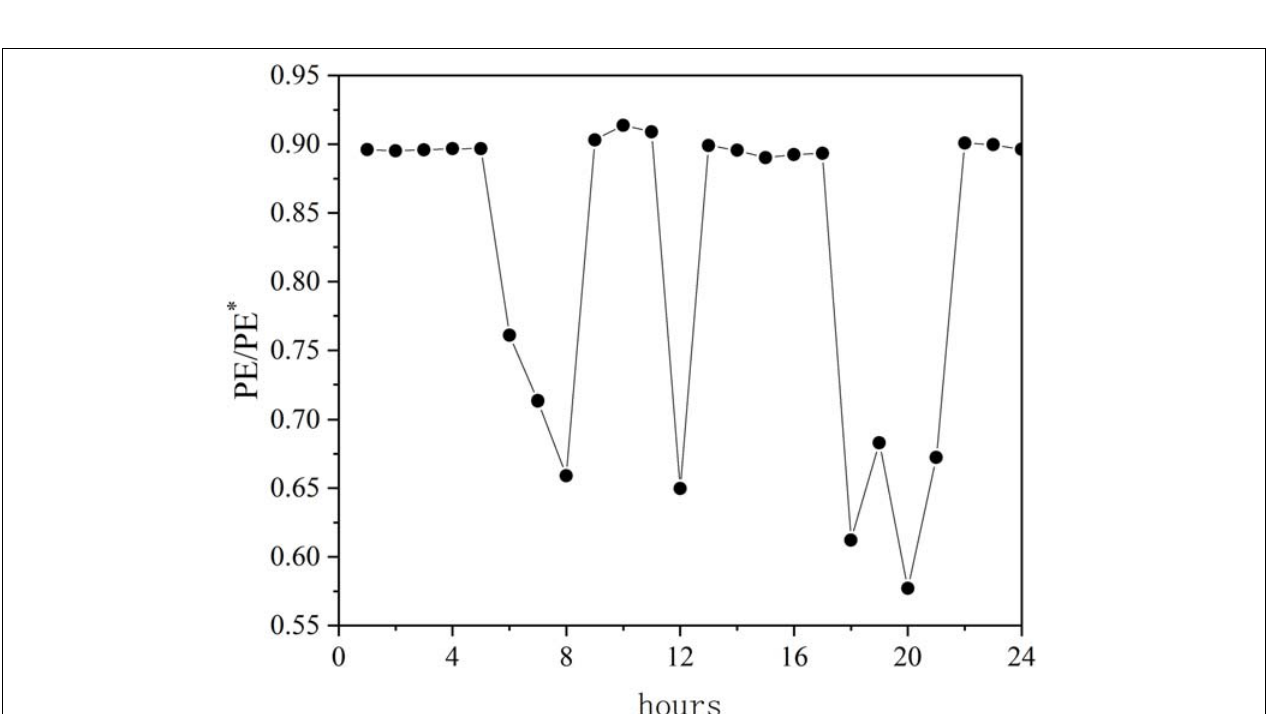
FIGURE 8 | Typical hourly energy consumption ratio in